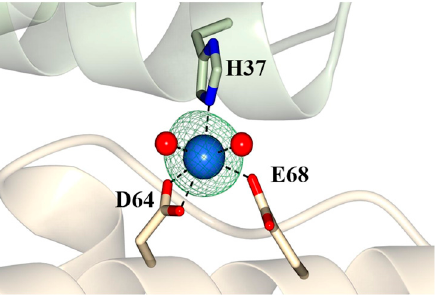
Figure 5. Mn (blue sphere) coordinated by ferroxidase ligands H37 (subunit 1) and D64 and E68 (subunit 2) occupies the same site as Na + in the Dps-o structure (Figure S1) and Fe1 in the Dps-c-Fe and Dps-o-Fe structures (Figure 3). The Fo-Fc omit map (green mesh) is contoured at 5 σ .